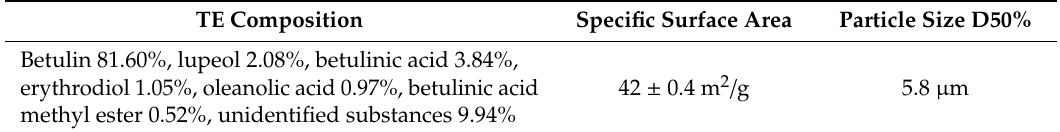
Table 1. Physical–chemical characteristics of the birch bark dry extract (TE) used